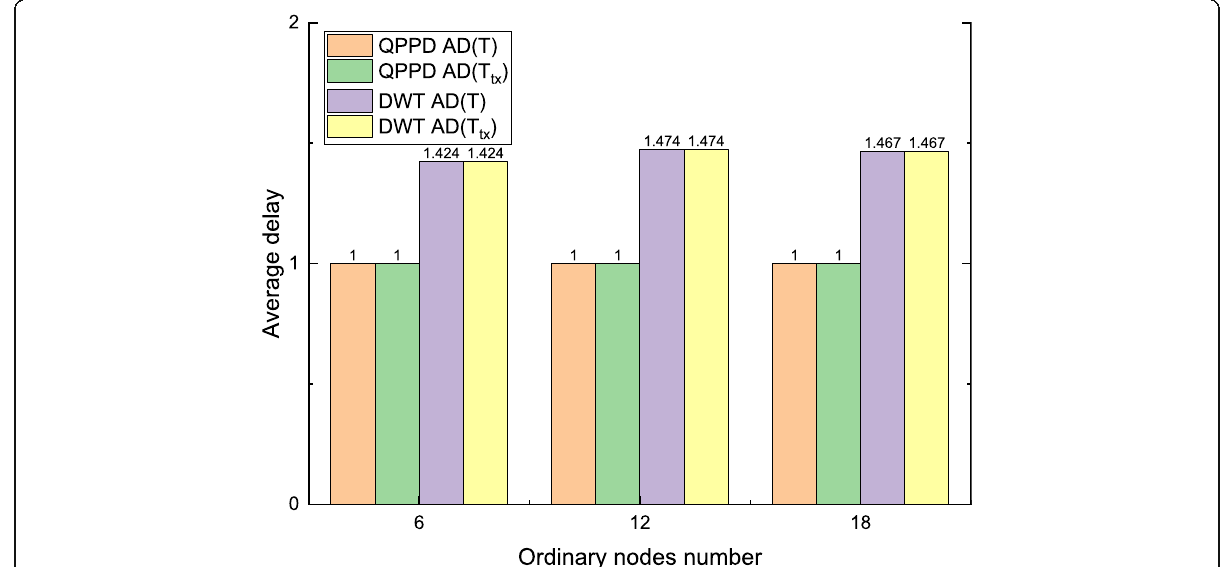
Fig. 32 The total volume of data is equal to 2 in each cycle; the average delay of high priority